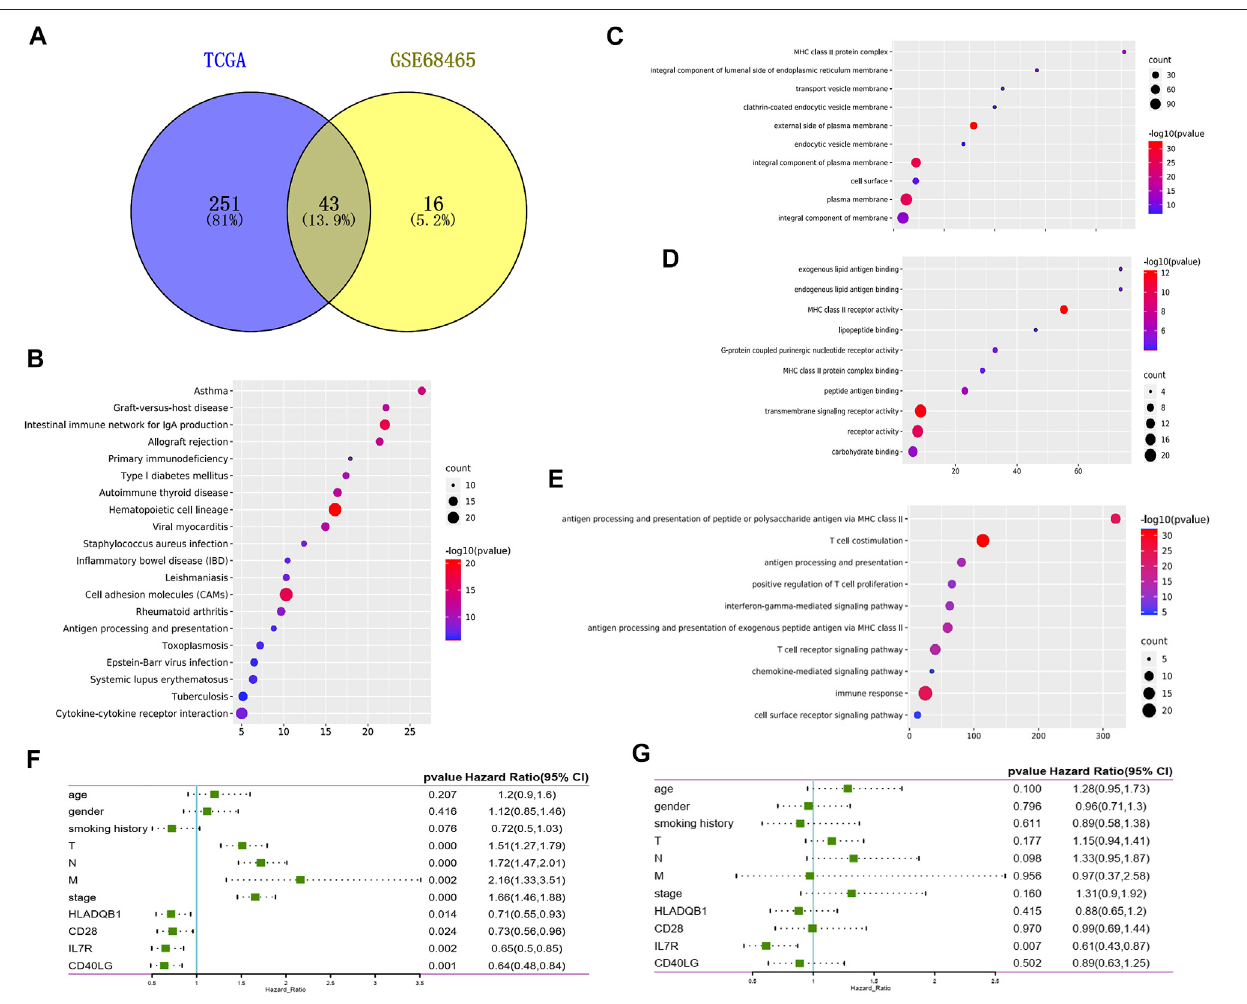
FIGURE 4 | Screening prognostic genes for lung adenocarcinoma. (A) Venn plot showed the prognostic gene shared by the TCGA and GSE68465 dataset in univariate COX analysis. (B) Bubble plots showed the annotation of the prognostic gene in KEGG pathway. (C – E) Top 10 GO terms of the prognostic gene. False discovery rate (FDR) of GO analysis was acquired from the DAVID functional annotation tool, p < 0.05. (F) Univariate Cox survival analysis of immune microenvironment related prognostic genes based on TCGA lung adenocarcinoma data. (G) Variate Cox survival analysis of immune microenvironment related prognostic genes based on TCGA lung adenocarcinoma